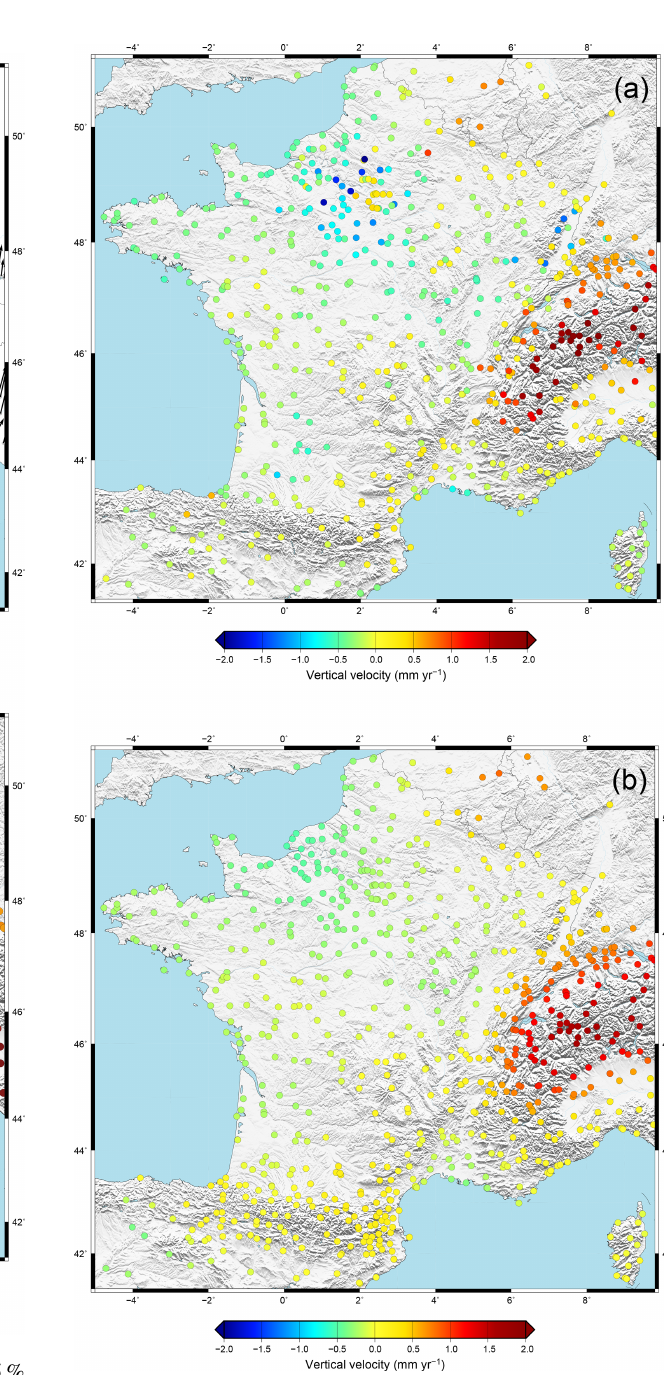
Figure 5. Vertical velocities (a) from clustering and (b) from Gaus- sian